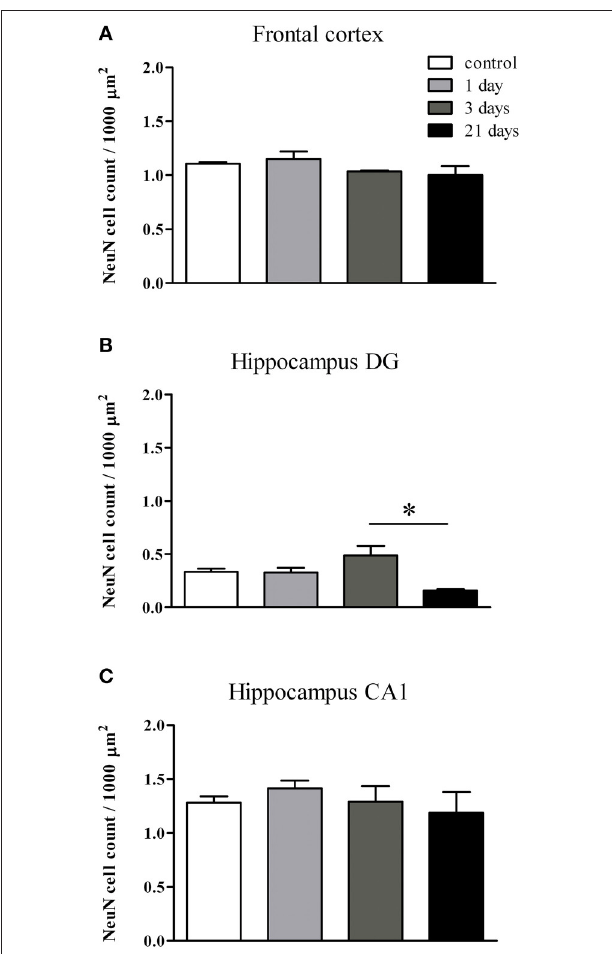
FIGURE 11 | Quantification of NeuN immunoreactive cells in the frontal cortex and hippocampus of rats following restraint stress. The graphs represent the densities of NeuN expressing cells: frontal cortex (A) , dentate gyrus of hippocampus (B) , CA1 region of hippocmapus (C) . Values for each group are means ± SEM. Data were analyzed by One-way ANOVA followed by Kruskal–Wallis test and Dunn’s multiple comparison tests. * p < 0.05 , significant difference as compared with the 3-day-stress